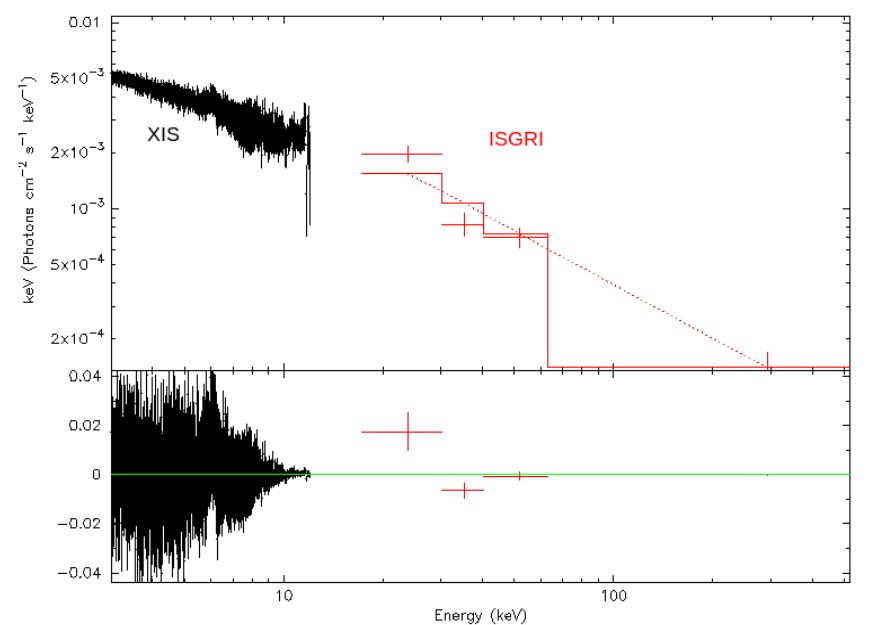
Figure A8. Unfolded Suzaku/XIS and INTEGRAL/ISGRI spectra of 3C 111 during 8th observational period (September 2010) and model. Above: all the spectra are shown by crosses; fitting curves are shown by solid lines; model components are shown by dotted lines; below: data residuals. During this period nuclear emission was zero-compatible, as well as the Fe-K α emission line. This spectrum can be considered as a pure jet base